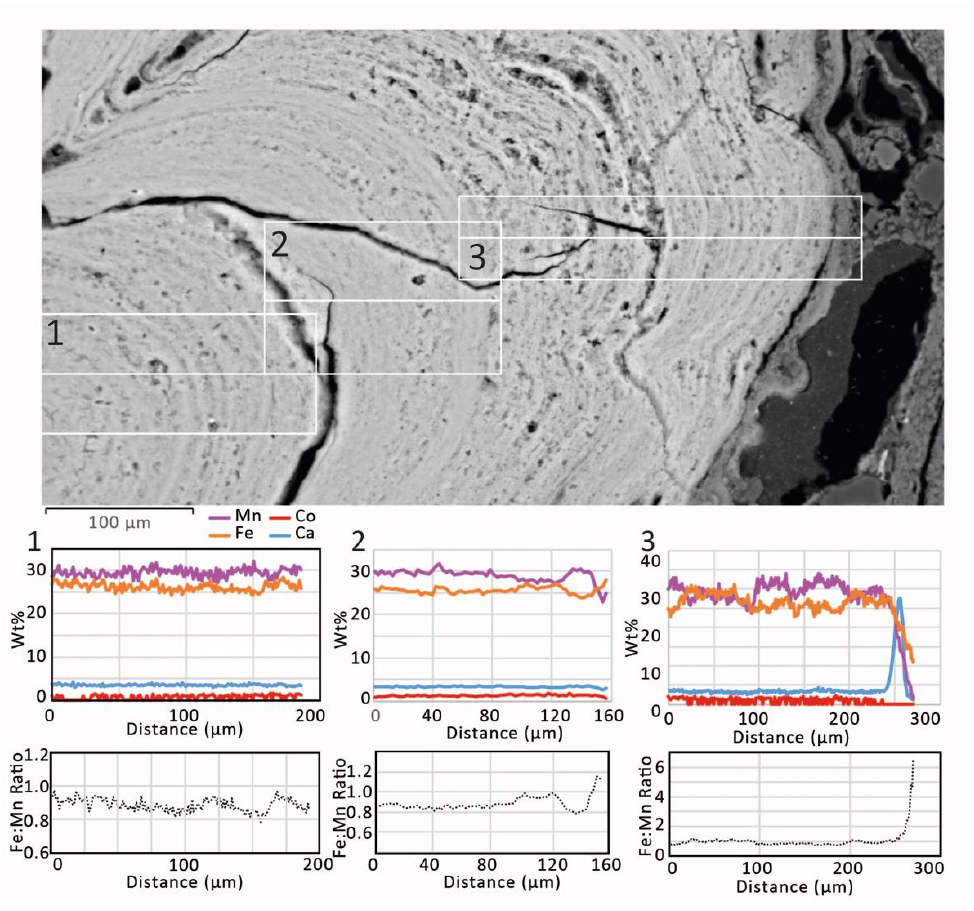
Figure 9. Compositional variations in Mn, Fe, and Co (and Ca) along transects measured with SEM-EDS and their Fe/Mn ratios. The white boxes indicate the area analyzed. The smoother profiles in line 2 are due to a slightly wider analysis area. Lines are run from left to right.